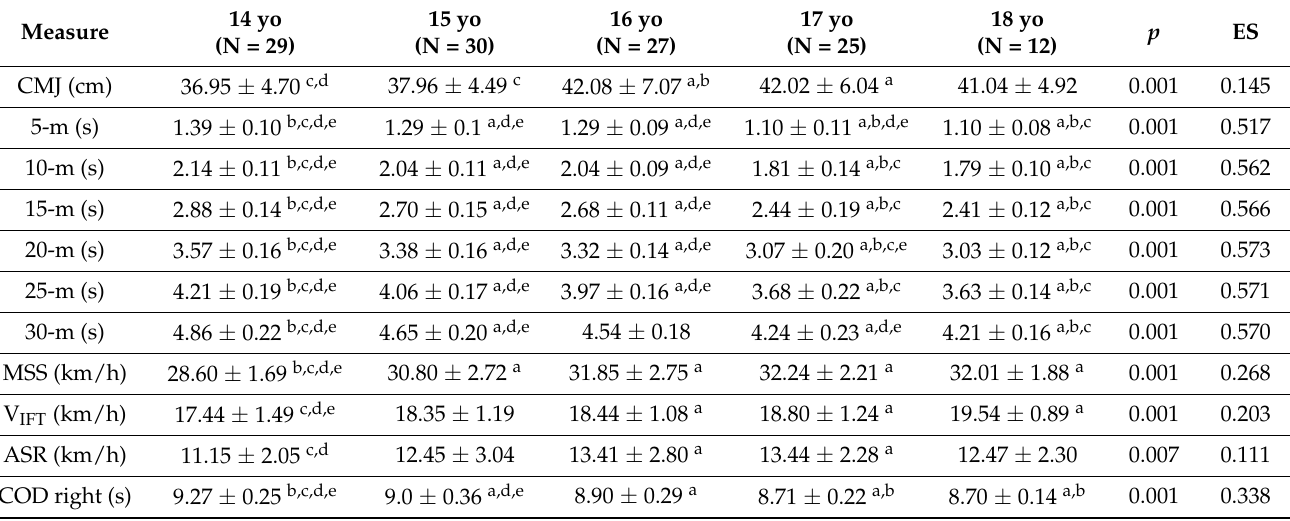
Table 2. Descriptive statistics (mean and standard deviation) for the physical fitness outcomes between